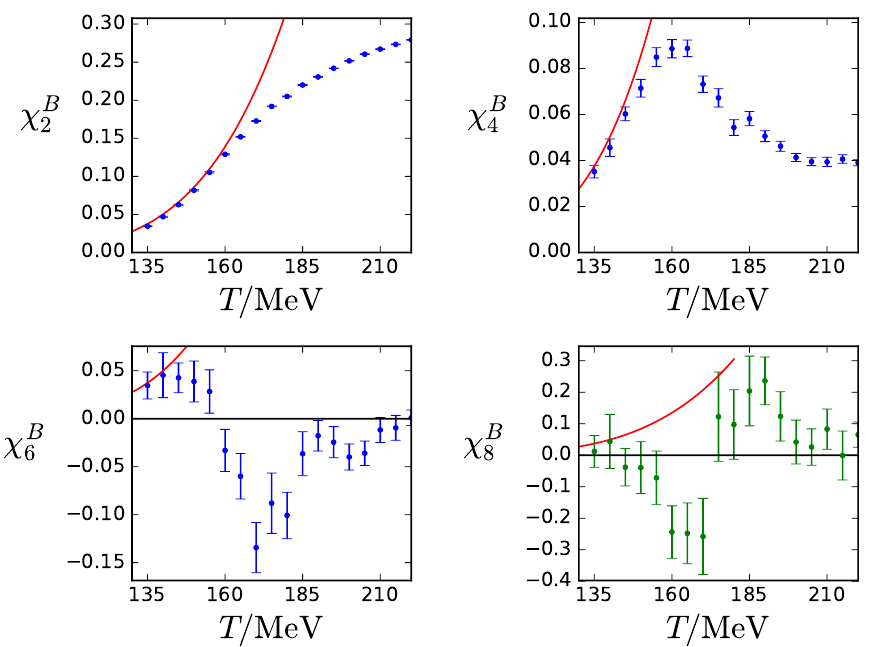
, (cid:31) B , (cid:31) B and an estimate for (cid:31) B as functions of the temperature, obtained 2 4 6 8 in green to point out that its determination is 8 observable by eq. (3.5). The red curve in each panel 4